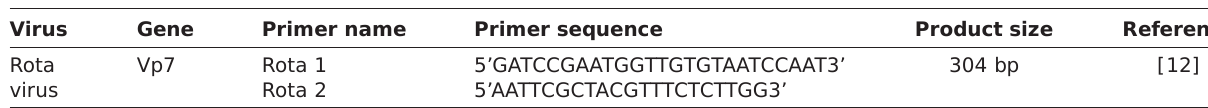
Table-2: Primers used in the study. Virus Gene